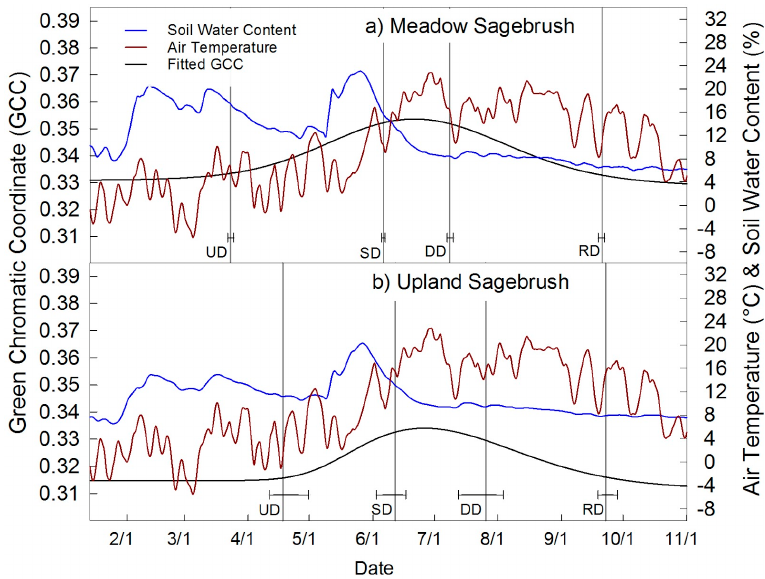
Figure 5. Seasonal course of GCC and phenophase dates are shown for ( a ) the dry meadow sagebrush canopy and ( b ) for the upland sagebrush canopy, plotted with 3-day average air temperature and soil water content. The dry meadow sagebrush had a longer growing season and increased greenness relative to the upland sagebrush canopy.